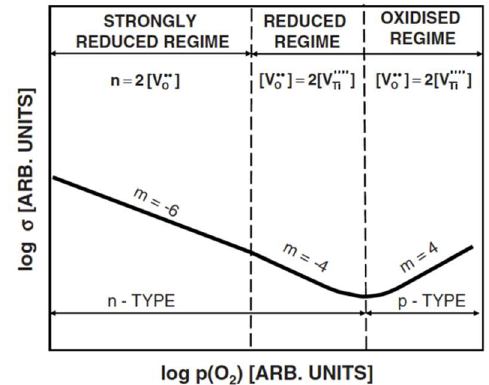
Figure 14. Effect of oxygen activity on the electrical conductivity of Titania. Reproduced from [49], Copyright 2007, John Wiley and Sons.